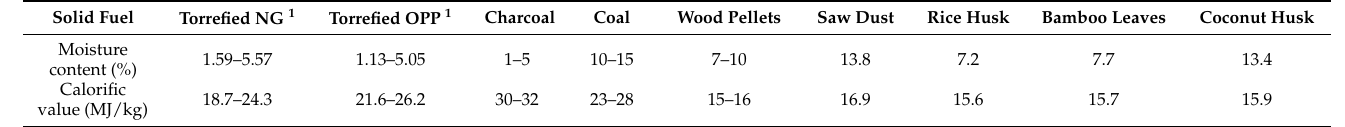
Table 2. Comparison of properties of our results with indicative fuels